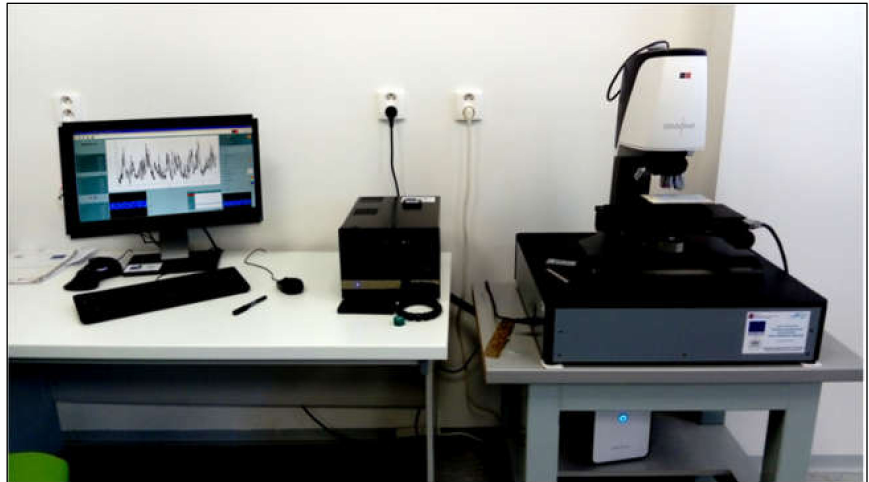
Figure 4. Optical profiler PLu neox 3D for surface topography